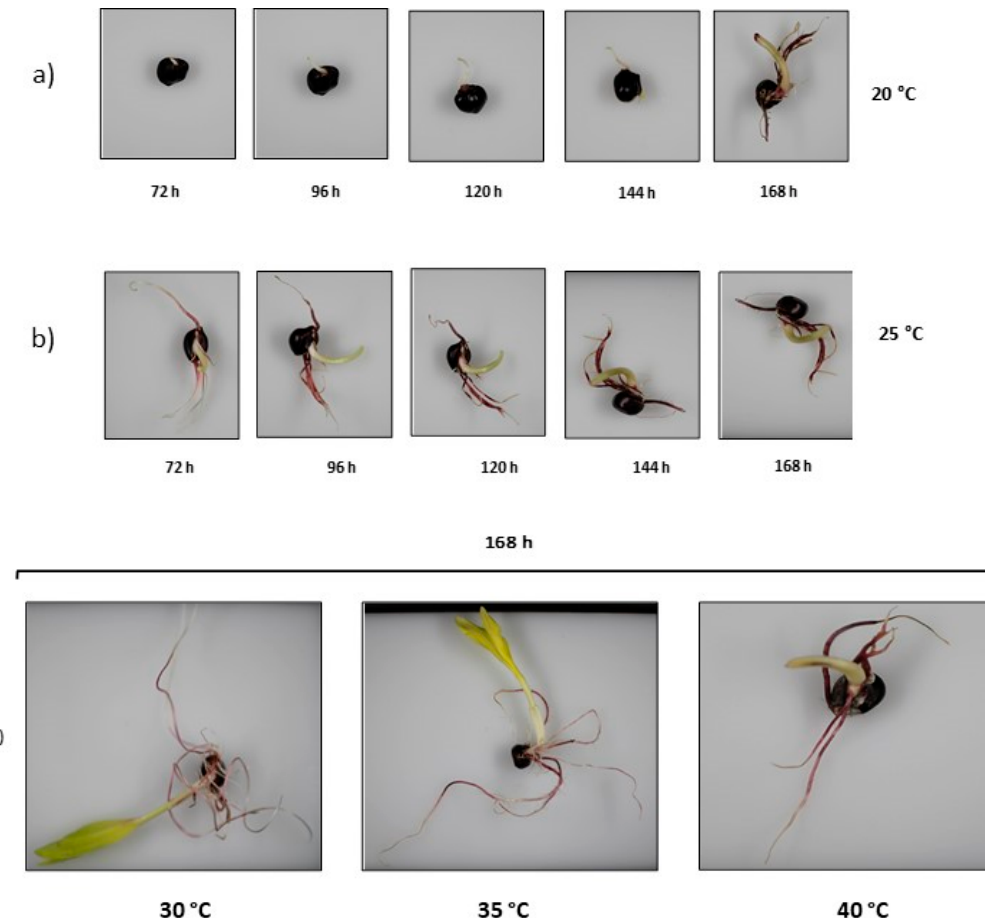
Figure 1. Pictures of germination of Andean purple corn. ( a ) Germination of purple corn seeds at 20 and 168 h; ( c ) germination of purple corn seeds at 30 ◦ C, 35 ◦ C, and 40 ◦ C for 168 °C for 72, 96, 120, 144, and 168 h; ( b ) germination of purple corn seeds at 25 °C for 72, 96, 120, 144, and 168 h; ( c ) germination of purple corn seeds at 30 °C, 35 °C, and 40 °C for 168 h.